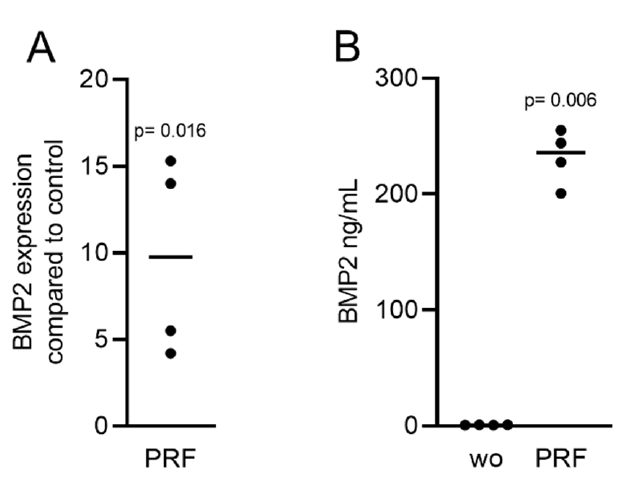
receptor 1 kinase signaling and thereby increase the expression of BMP2 and the related genes ID1 and ID3 (Figure 4A–C).